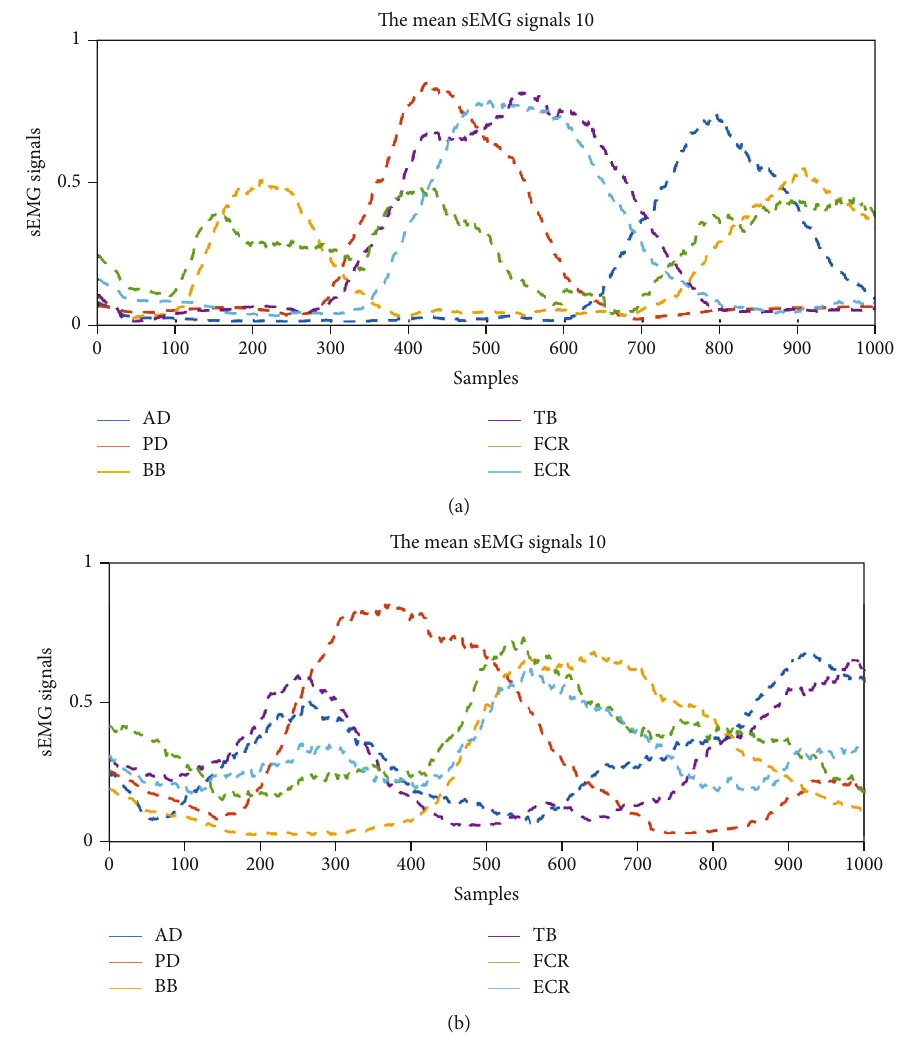
Figure 3: The typical sEMG results of six muscles in upper limb during the HRI with circle-drawing movements. (a) The sEMG results for counterclockwise circle-drawing movements; (b) the sEMG results for clockwise